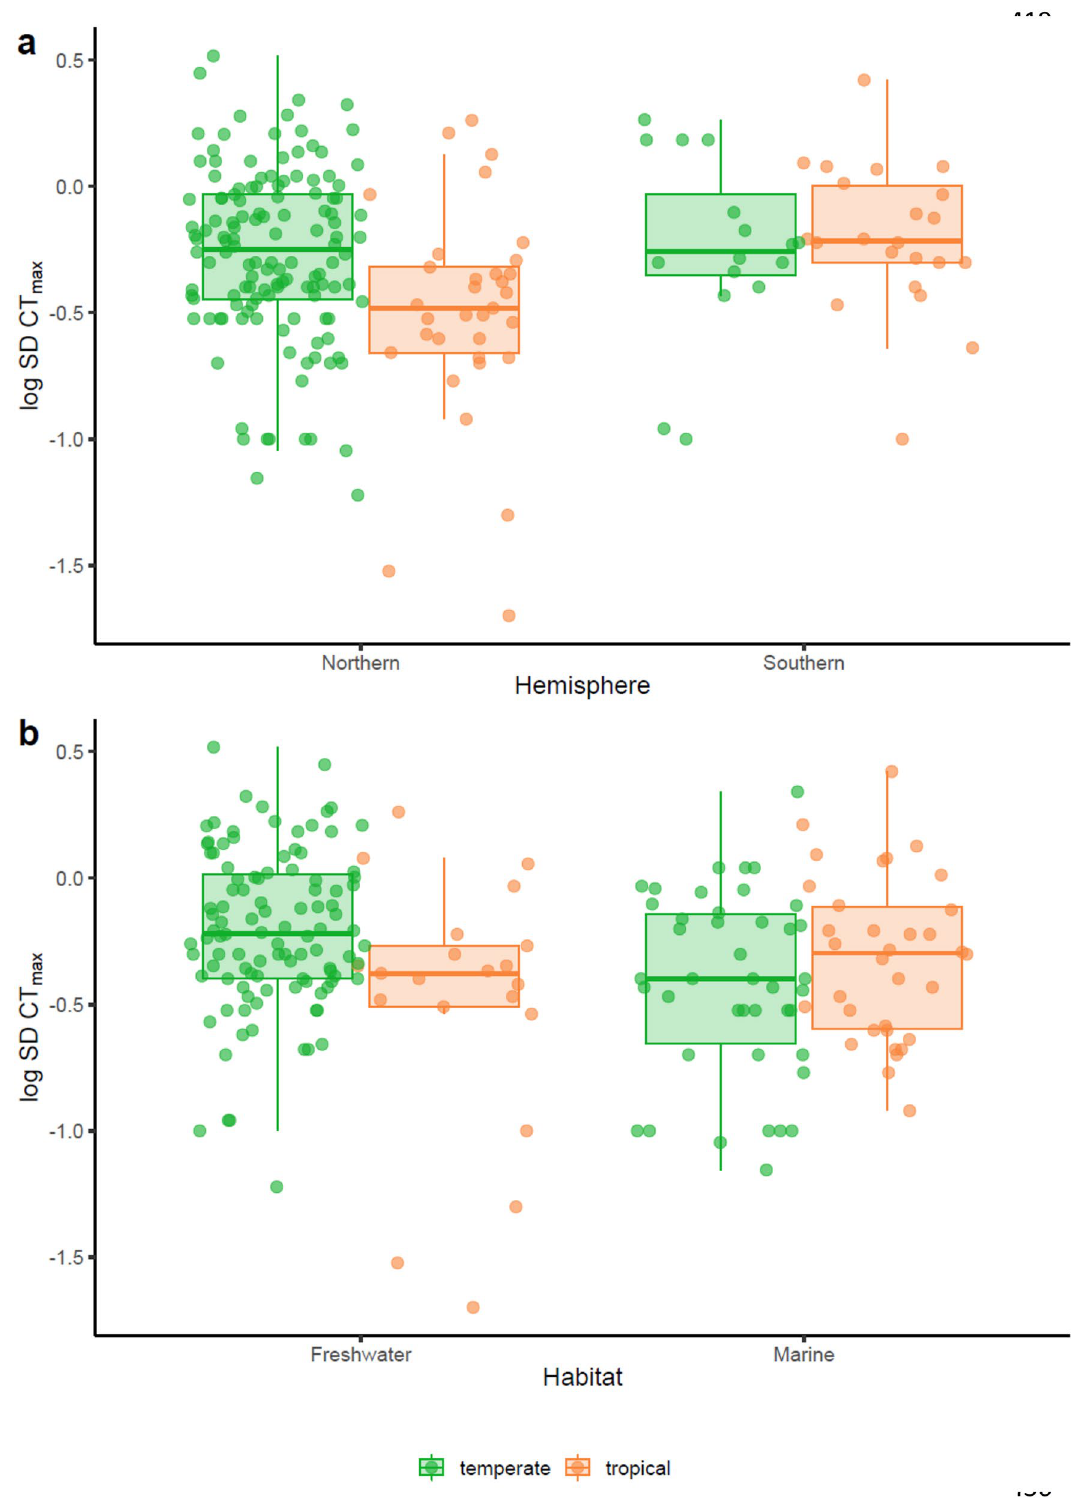
Figure 2. Intraspecific variation in CT max (log 10 transformed standard deviation CT max ) divided into either temperate (148 species) or tropical (55 species). ( a ) Separated by hemisphere, Northern (132 temperate, 33 tropical species) or Southern (16 temperate and 22 tropical species). ( b ) Separated into freshwater (106 temperate, 21 tropical species) and marine (42 temperate, 34 tropical